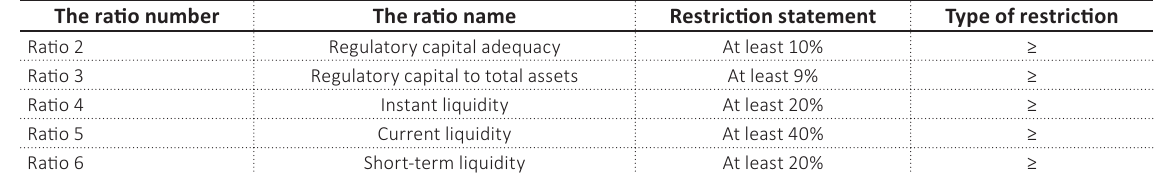
Table 1. Economic standards for operational control over the banking activities’ financial stability that are unilaterally restricted under the “at least” term or (≥)